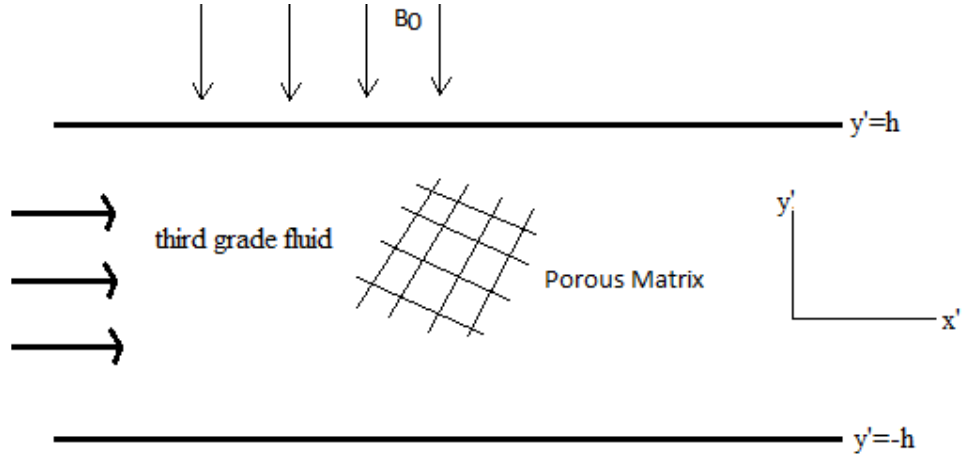
Figure 1. Flow geometry.